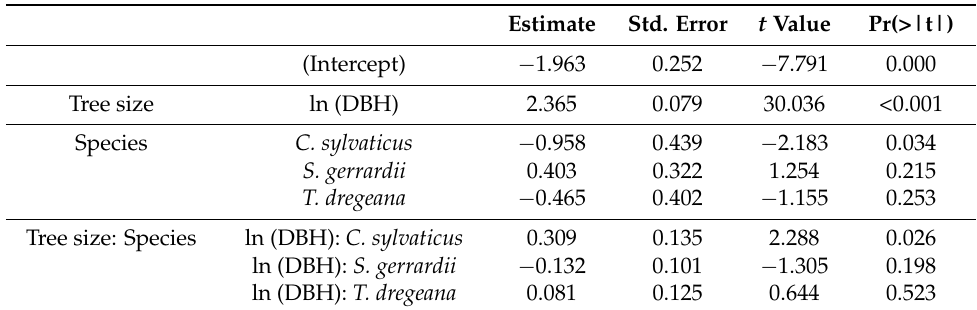
Table 2. Results of the generalised linear models showing the effects of species and size on the aboveground biomass (AGB).